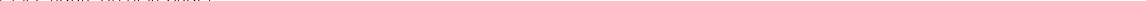
WSSV load/g shrimp